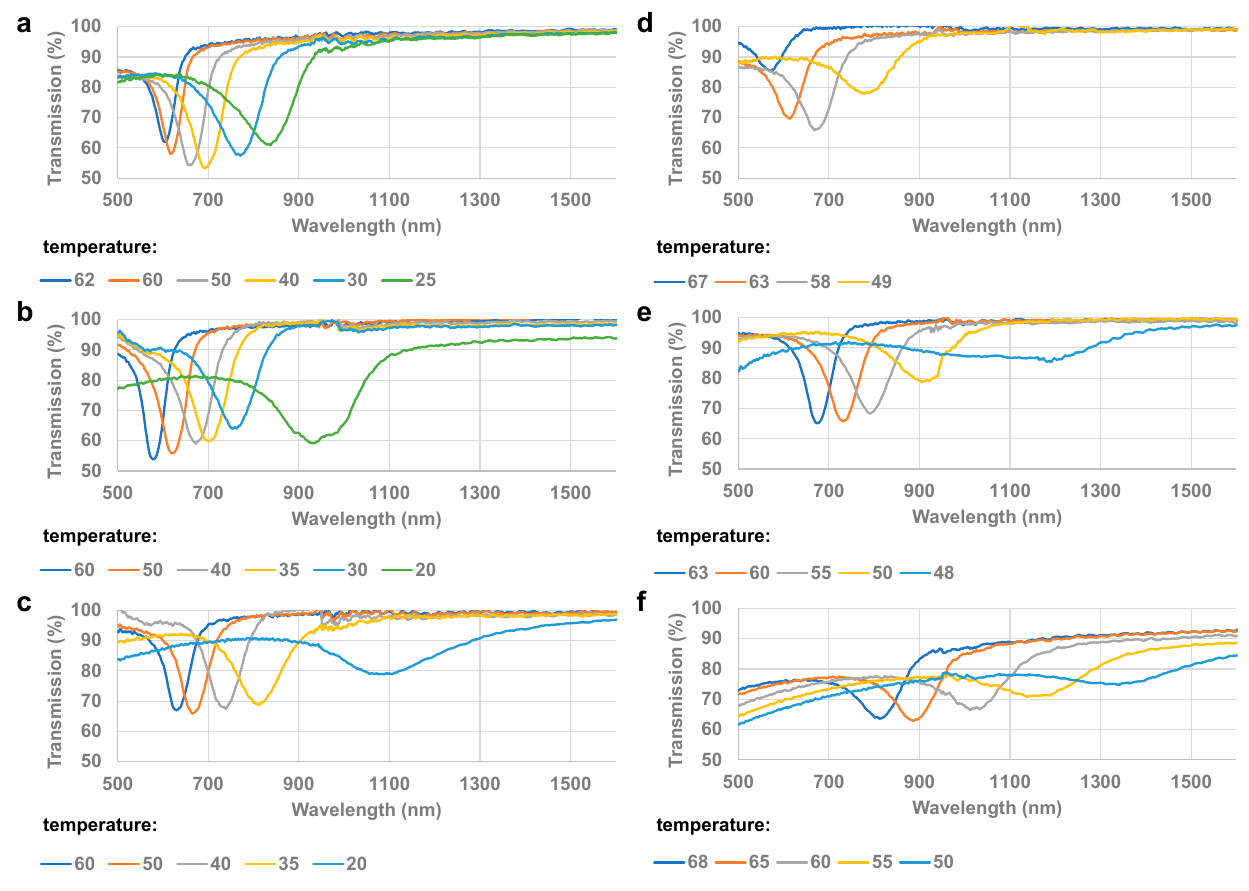
Figure 3. UV-Vis transmission spectra of films of the end-capped cholesteric oligomers at various temperatures. The temperatures given were set on the heating stage; the sample temperatures might be slightly lower. The graphs on the left side display the spectra of oligomers without smectic monomer of ( a ) DP 2.0, ( b ) DP 3.0, and ( c ) DP 5.0. The graphs on the right display the spectra of oligomers with 25% smectic monomer of ( d ) DP 2.0, ( e ) DP 3.0, and ( f ) DP 6.3. The data of figure can be obtained in Supplementary Materials.